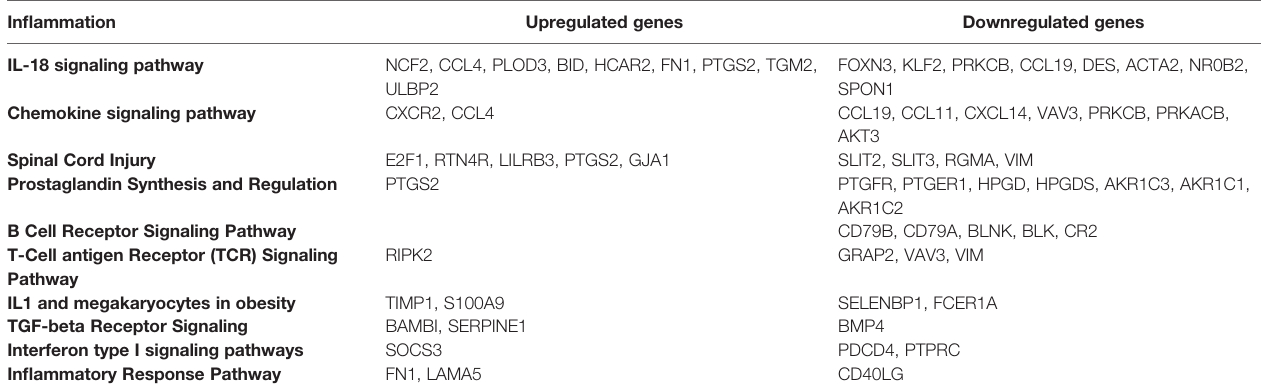
TABLE 3 | Principal pathways of In fl ammation Cluster for the subset B.